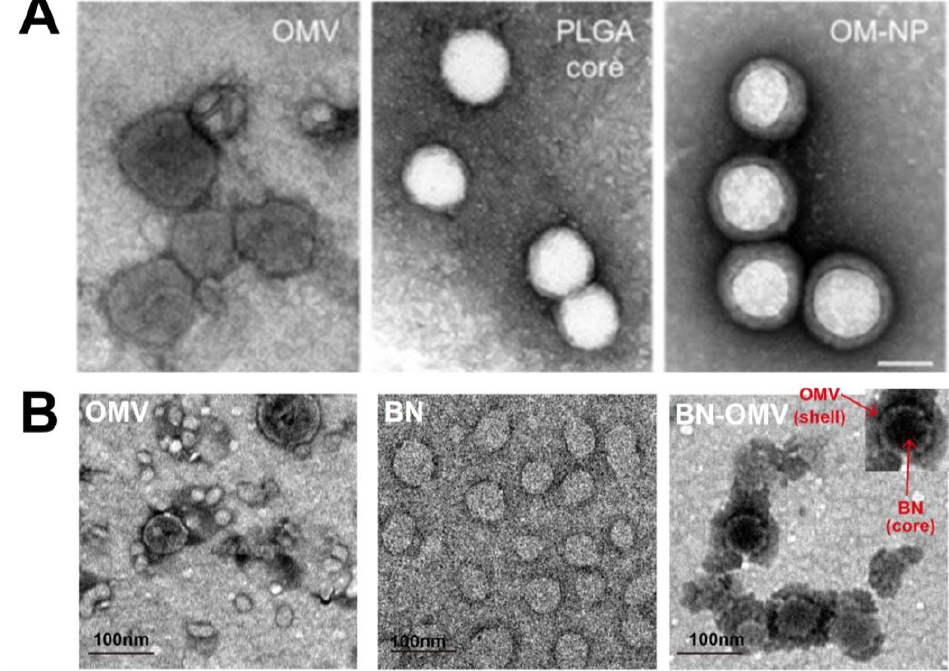
Figure 3. Transmission electron microscopy (TEM) images of ( A ) OMV-PLGA: OMVs, PLGA cores, and OM-NPs and ( B ) BN-OMVs: OMVs, BN, and BN-OMVs. Reproduced with permission from Reference [19] and Reference [17], respectively. Reference [19] John Wiley and Sons, 2019 and Reference [17], Elsevier, 2020,